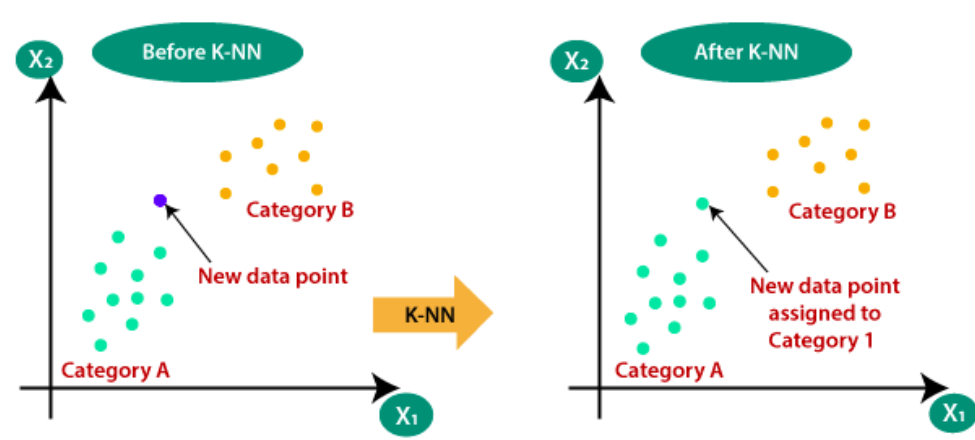
Figure 4. An illustration of the K-NN classifier algorithm in